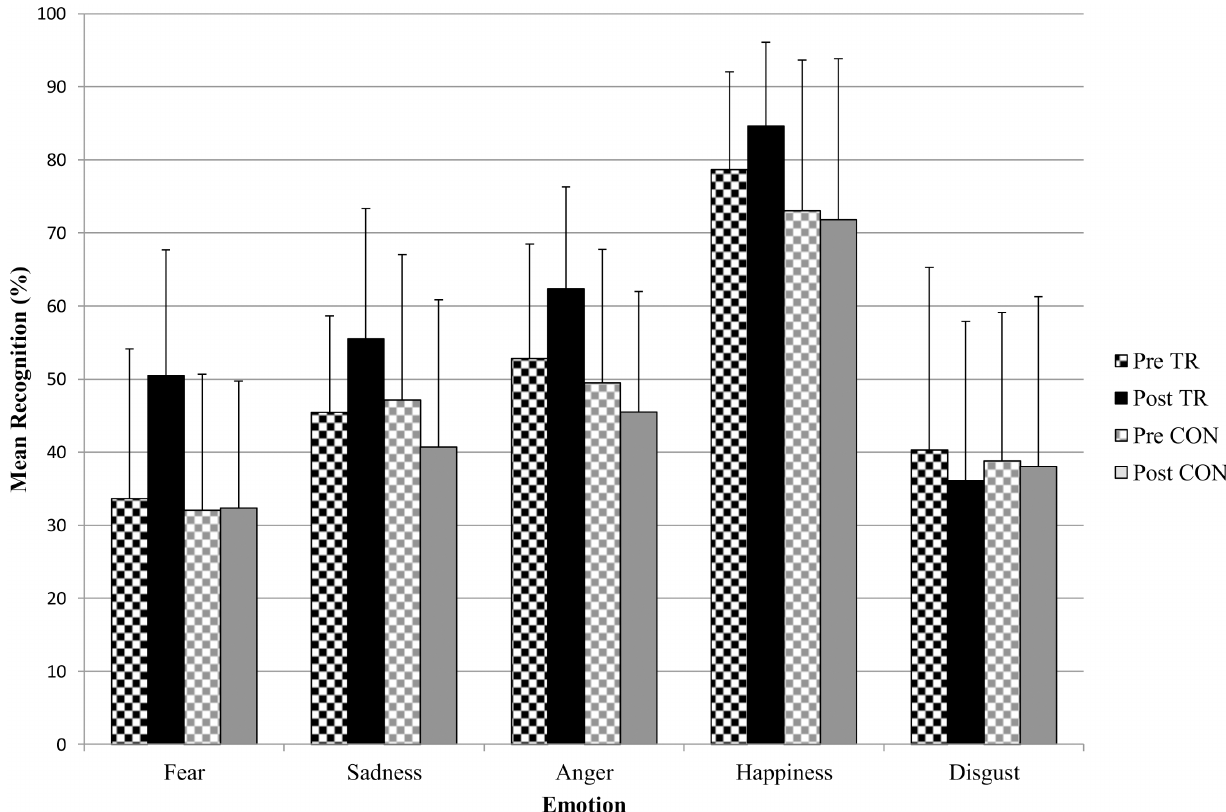
Fig 1. Mean fear, sadness, anger, happiness and disgust recognition scores for young offenders in the Training (TR) or Control (CON) group at pretest (Pre) and retest (Post). Error bars show +1 standard deviation.